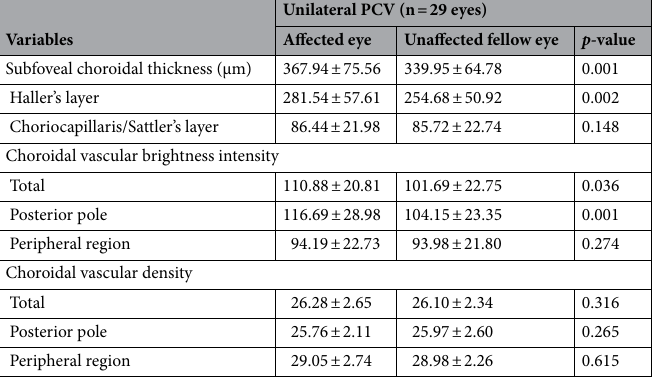
Table 3. Comparison of choroidal parameters between affected and unaffected fellow eyes in unilateral PCV. PCV polypoidal choroidal vasculopathy.